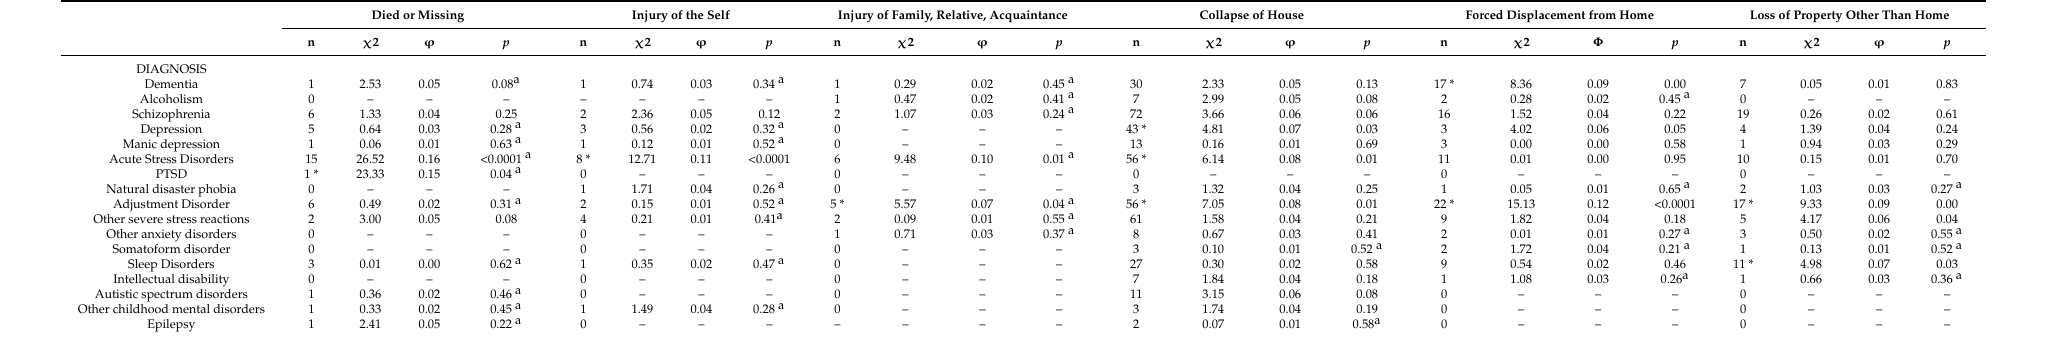
Table 4. Diagnosis in Four Disasters: Comparison with Disaster